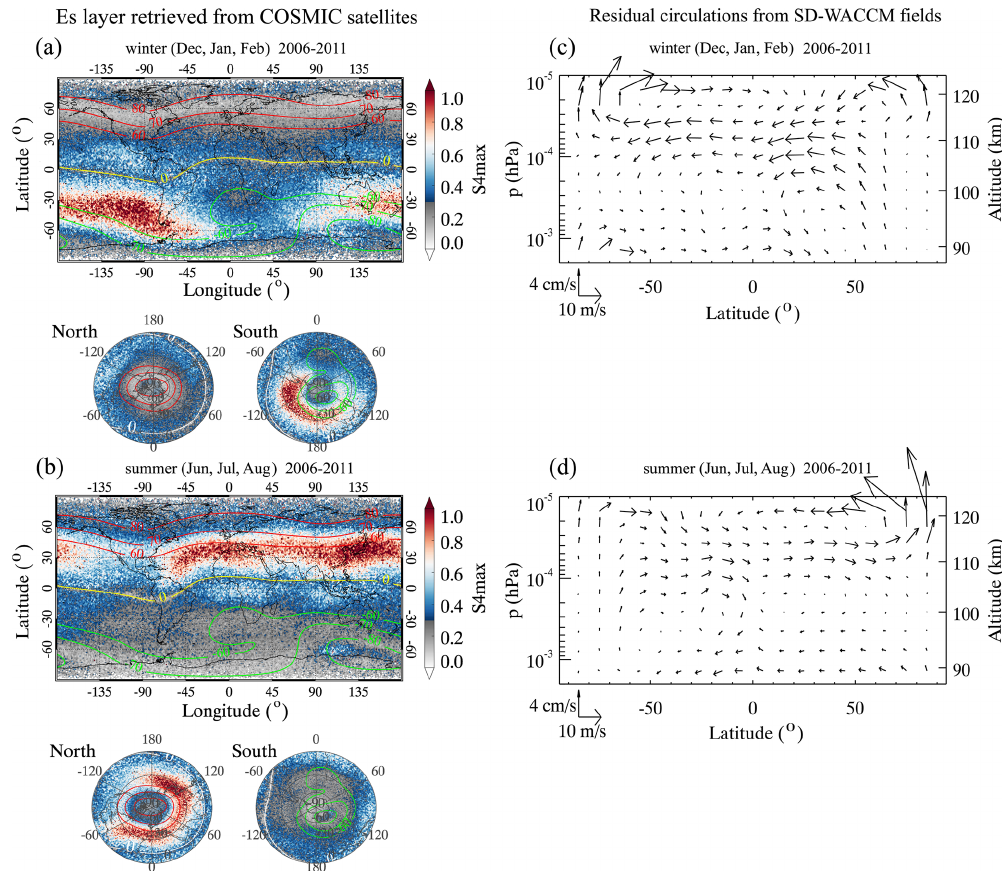
Figure 2. Global distributions of the mean E s layer intensity represented by the S4max index from COSMIC are shown in (a) and (b) for the winter (December, January, February) and summer (June, July, August), respectively, between 2006 and 2011, detected from COSMIC multi-satellites with a resolution of a 1 ◦ × 1 ◦ . The red and green curves represent the geomagnetic latitude contours of 60, 70, and 80 ◦ in the Northern Hemisphere and Southern Hemisphere, and the yellow curve represents the geomagnetic Equator. The mean residual circulations are calculated for winter (c) and summer (d) using the SD-WACCM4 (2006–2011). There are three circulation cells: mesospheric circulation, lower thermospheric circulation, and thermospheric circulation. Below 95km, the summer-to-winter mesospheric circulation is driven by gravity-wave forcing. Between 95 and 115km, the winter-to-summer lower thermospheric circulation is driven by gravity-wave forcing that is in the opposite direction to that which drives the mesospheric circulation. Above 115km, the solar-driven thermospheric circulation is a summer-to-winter